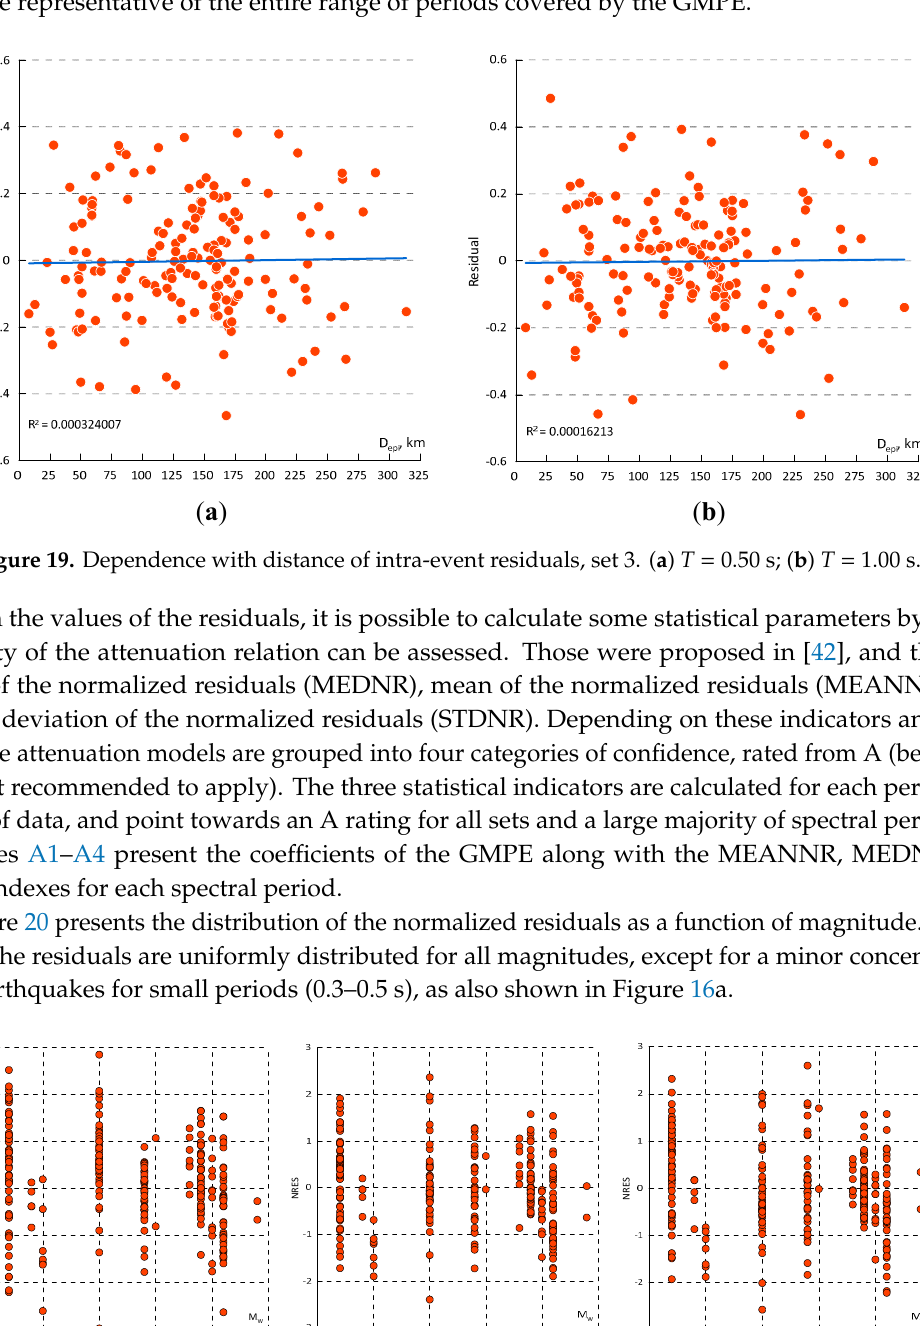
Figure 18. Inter-event residuals dependence on magnitude, set 3. ( a ) T = 0.50 s; ( b ) T = 1.00 s.